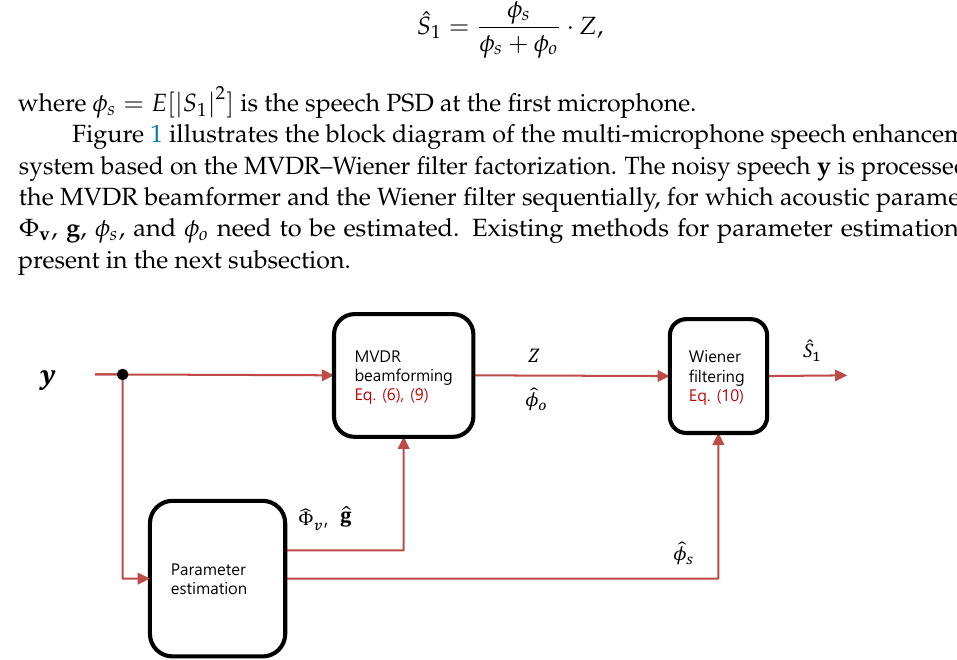
Figure 1. Block diagram of the multi-microphone speech enhancement system based on the MVDR– Wiener filter